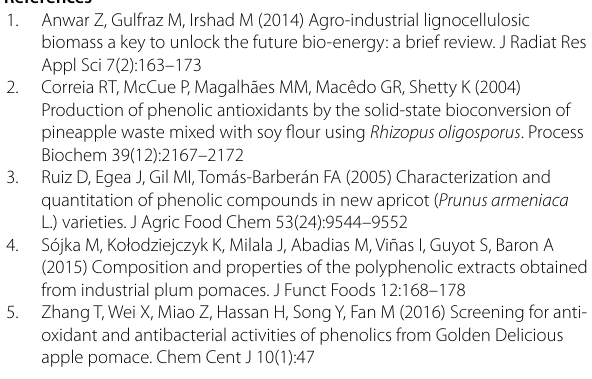
Values are the means of three measurements (n 3). Different superscript letters (a–c) in the same row indicate significant differences (p < 0.05) among fatty acids = of the unfermented and fermented substrates (ANOVA “Tukey’s Multiple Comparison Test”). C16:0 palmitic;